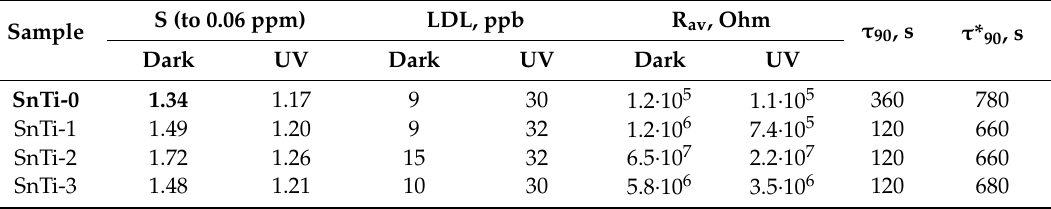
Table 5. Literature data on sensor response S = ( R air / R gas - 1)*100% of metal oxide semiconductor gas sensor in formaldehyde